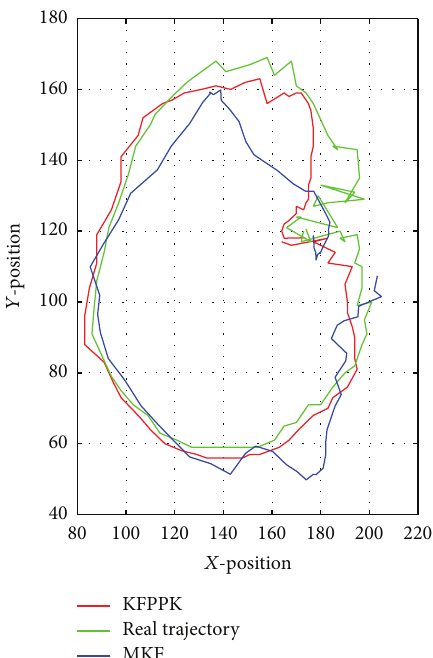
Figure 3: Trajectory results in the synthetic ellipse video sequence by the proposed approach KFPPK and the MKF tracking algorithms. We can see the KFPPK is closer to the real trajectory than the MKF tracking